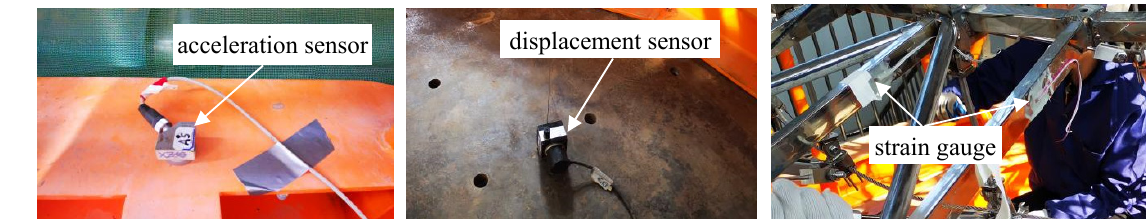
Figure 9. Acquisition instruments.